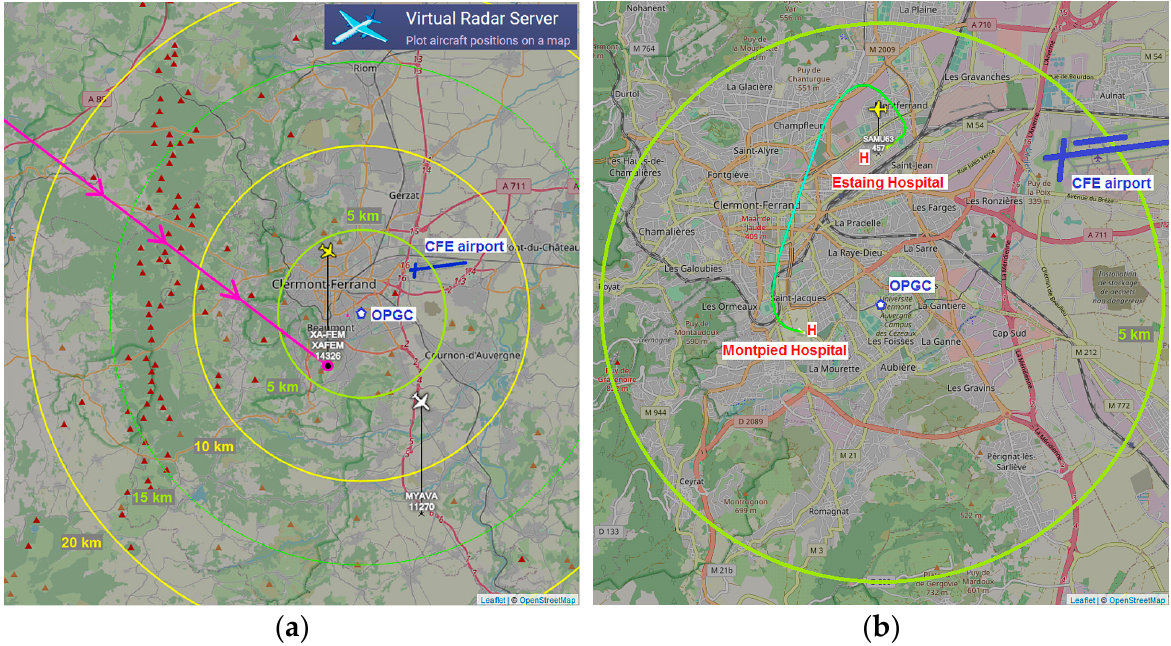
Figure 4. Screenshots from Virtual Radar Server based on OpenStreetMap showing an example of international flight (XA-FEM, Servicios Aereos Regiomontanos SA) ( a ) and of local flight (SAMU63, medical emergency helicopter) ( b ). Concentric yellow and green circles give the ground distance to the COPLid location.